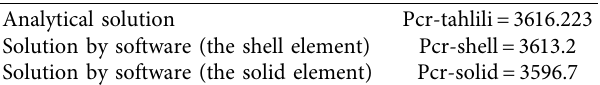
Table 4: Value of critical force obtained through analytical solution and solution by software.